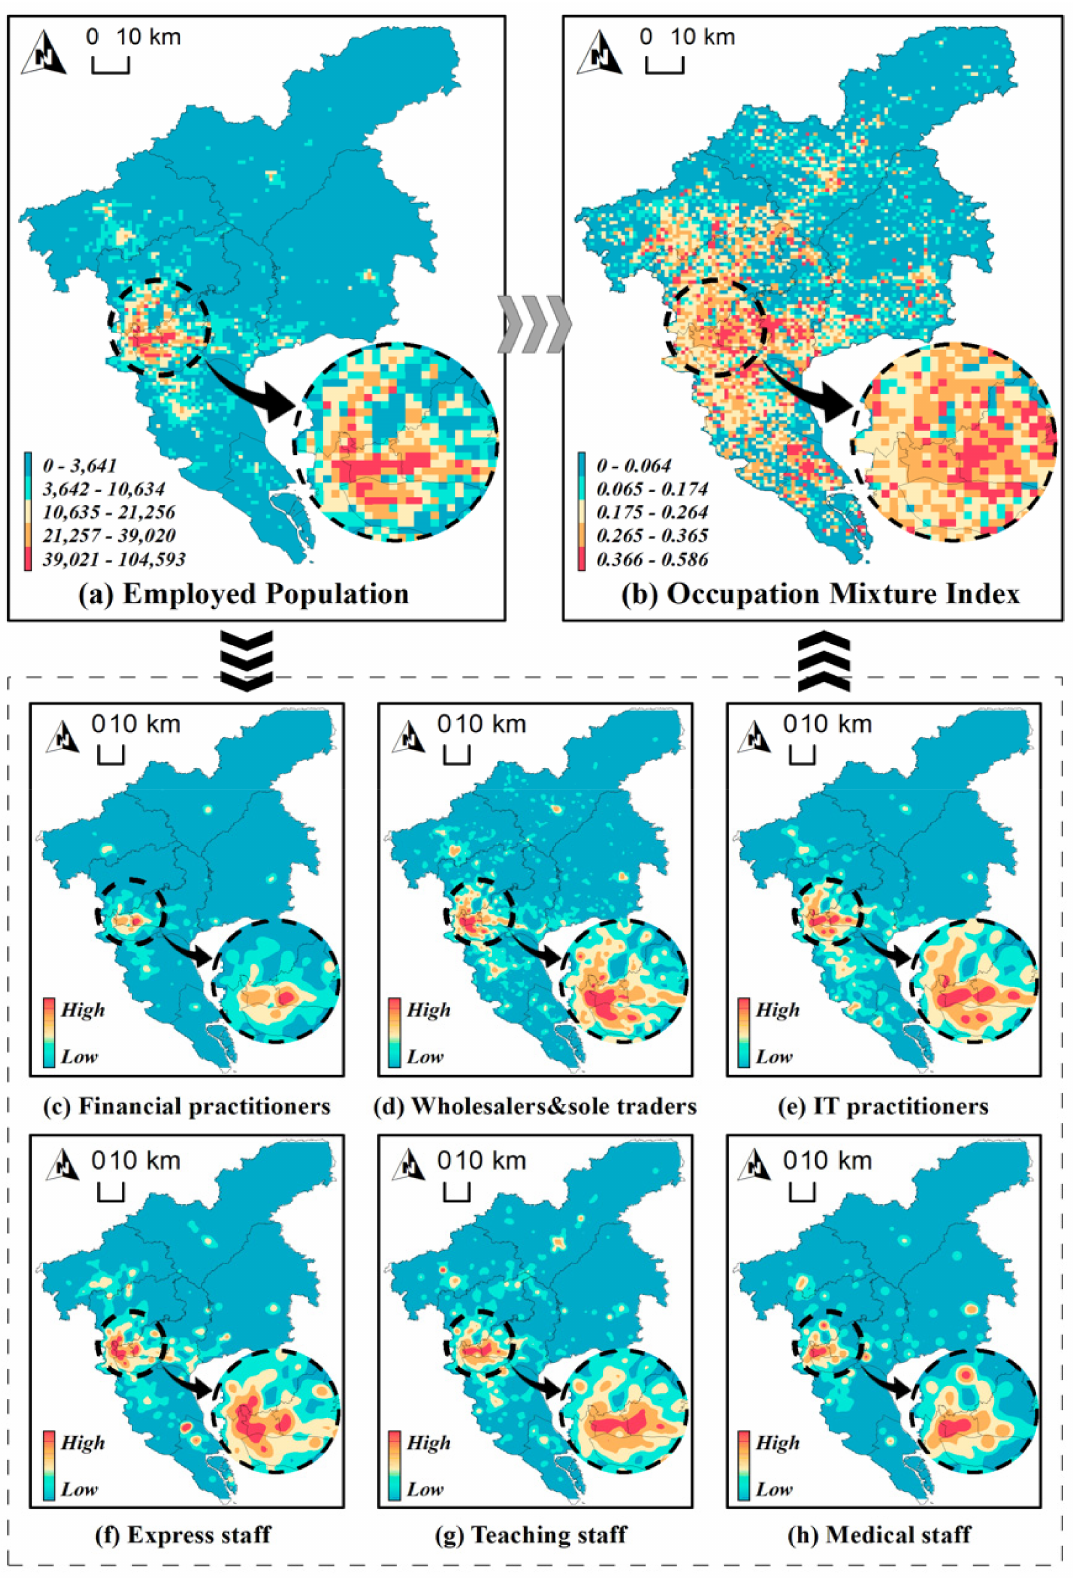
Figure 6. Spatial distribution of employed population ( a ), occupation mixture index ( b ) and six occupations’ work spaces: financial practitioners ( c ), wholesalers and sole traders ( d ), IT practitioners ( e ), express staff ( f ), teaching staff ( g ), medical staff ( h